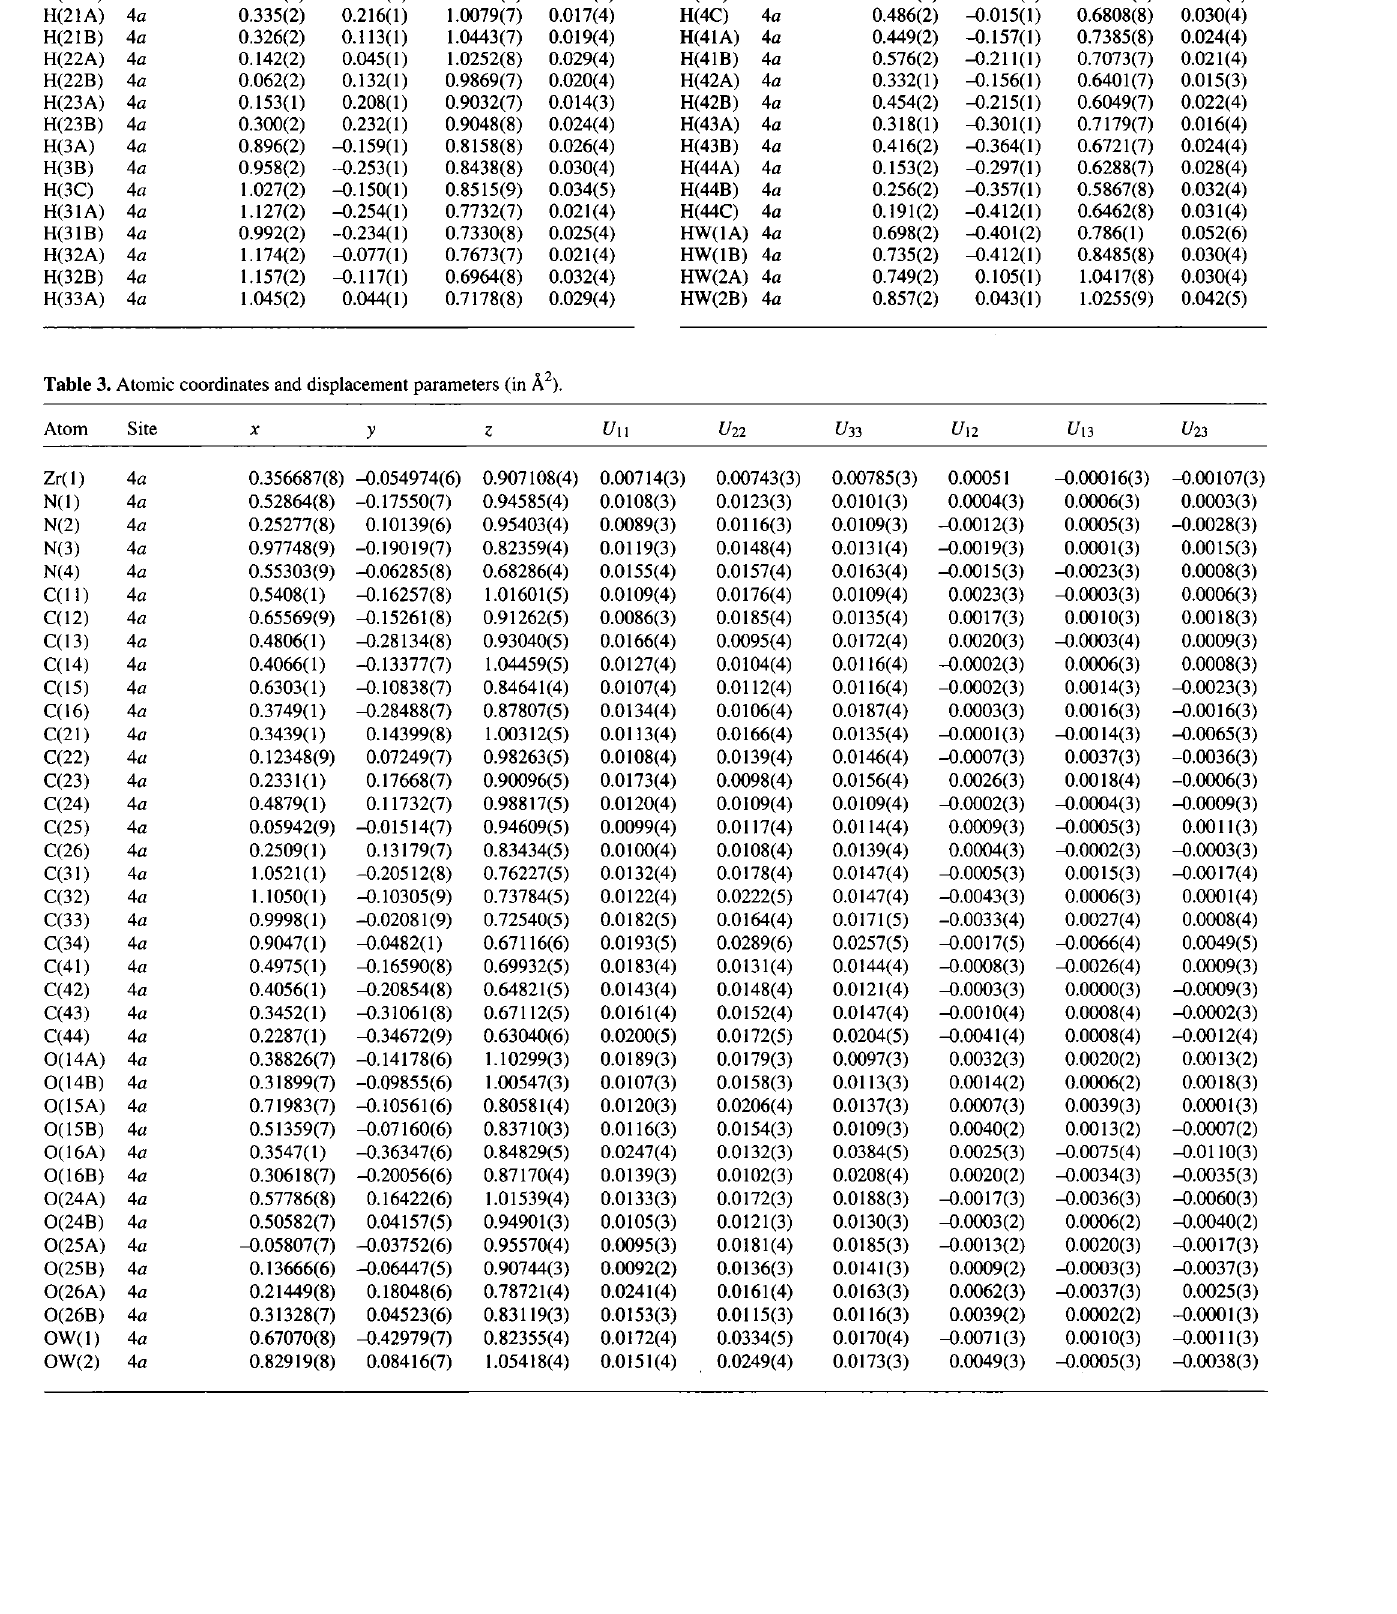
Table 3. Atomic coordinates and displacement parameters (in Ä 2